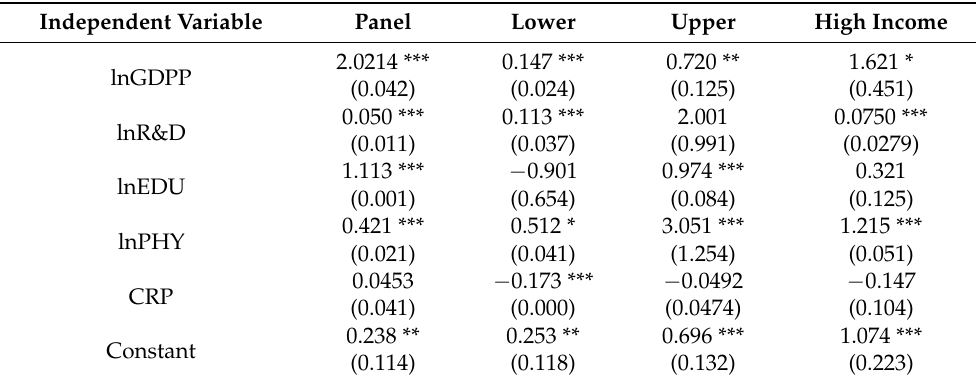
Table 7. Model 1: Simar and Wilson regression.